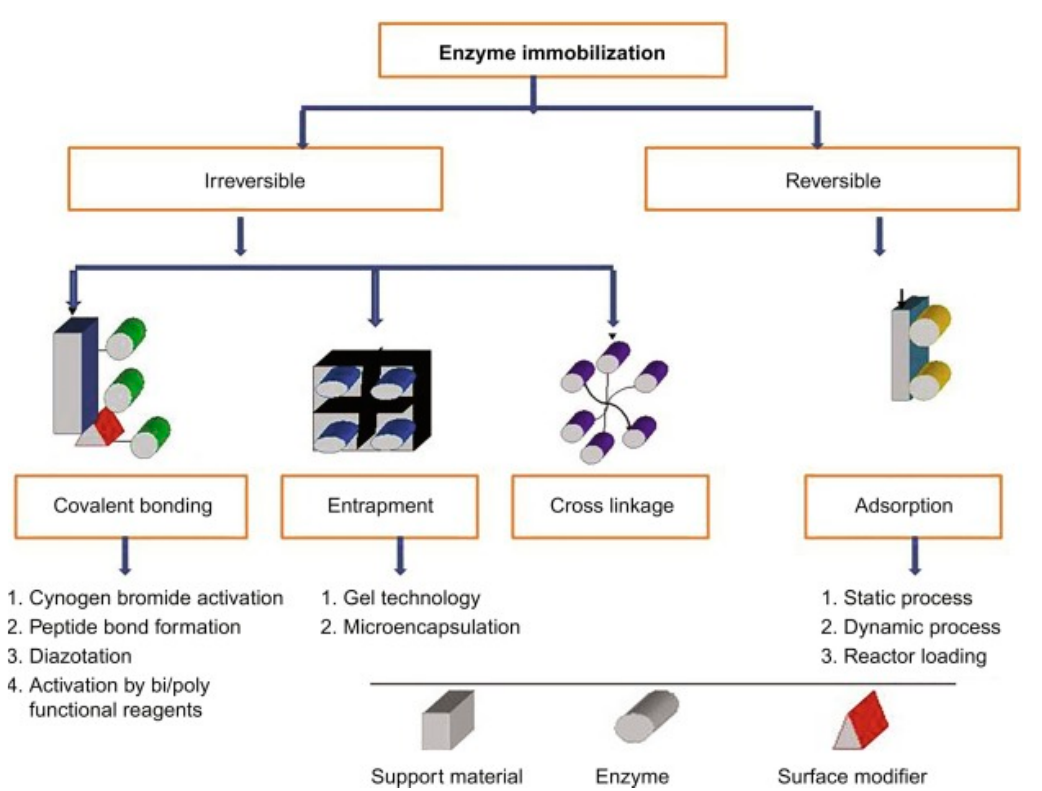
Figure 4. Classification and representation of different enzyme immobilization techniques. Reprinted with permission from [105]. Copyright 2023, copyright Elsevier.